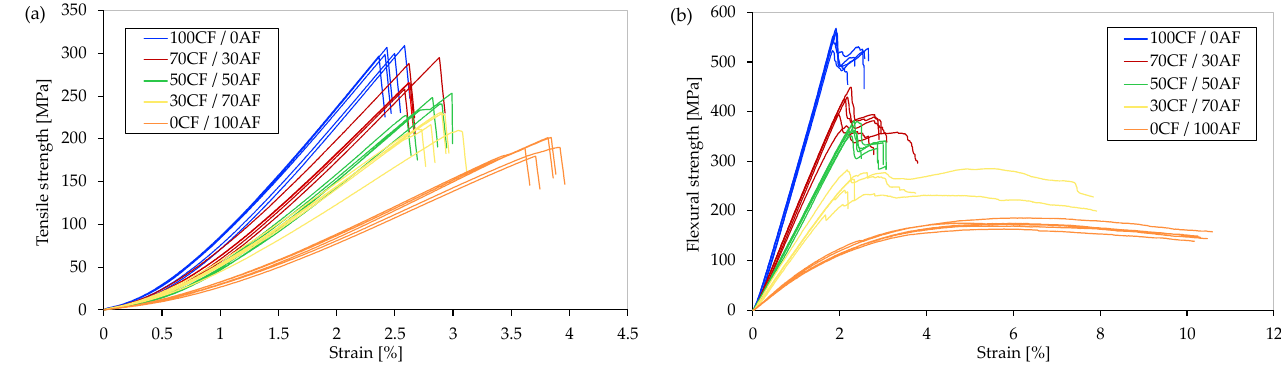
Figure 6. Stress–strain curves of the mechanical tests: ( a ) tensile tests; ( b ) flexural tests.